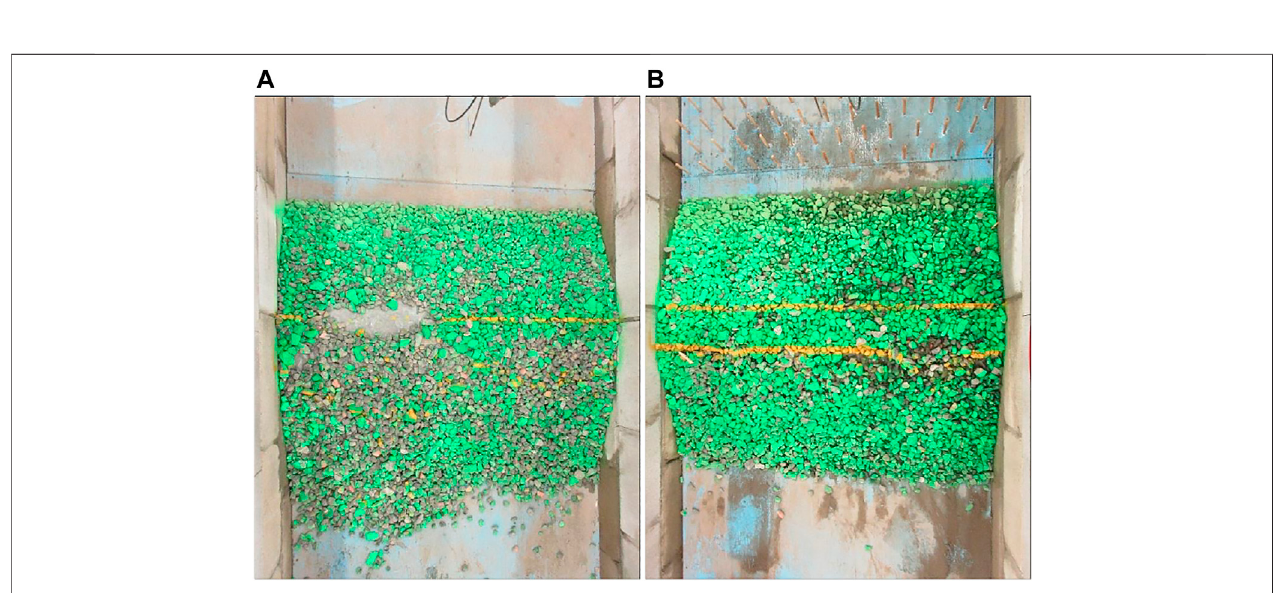
FIGURE14| Comparison ofdamagetoidentical dykesbuiltbehindasaltmarsh platform; withoutvegetation (A) andwithvegetation (B) .Wavesapproachedfrom the top in these images.